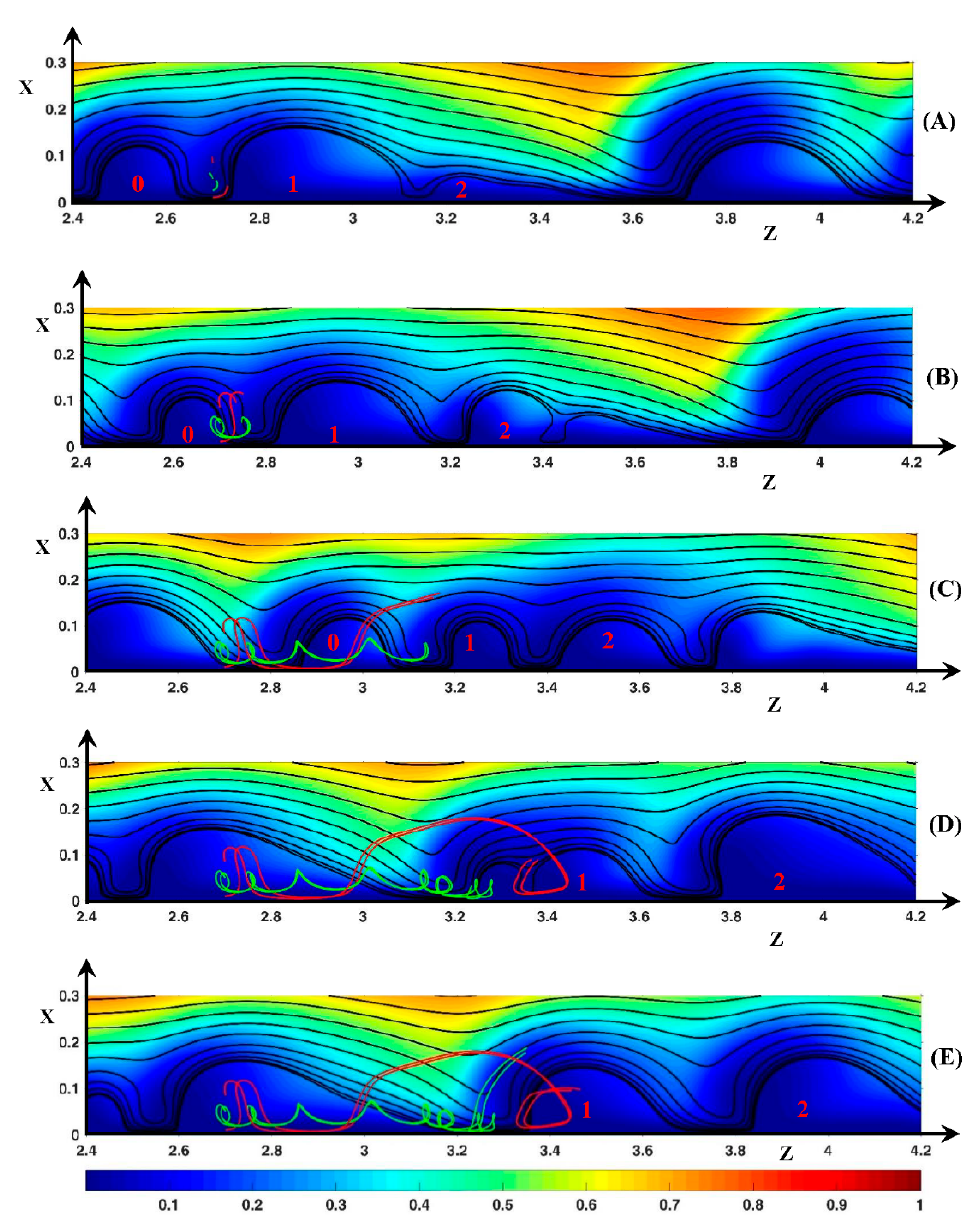
Figure 13. Fluid trajectories. Black lines: static streamlines starting from the inlet. Red and green lines: dynamic streamlines starting from z o = 2.7 ( x o = 0.01, 0.025, 0.05, 0.085). Color plot: cation concentration. Red numbers: vortex numbering. Vortex n ◦ 0 is the vortex upstream the trajectories source location at t ’ = 0. Vortex n ◦ 1 is the vortex downstream the source. ( A ) t ’ = 5; ( B ) t ’ = 45; ( C ) t ’ = 135; ( D ) t ’ = 220; ( E ) t ’ = 245. ∆Φ = 27, ν = 1/3 × 10 − 3 , D ± =